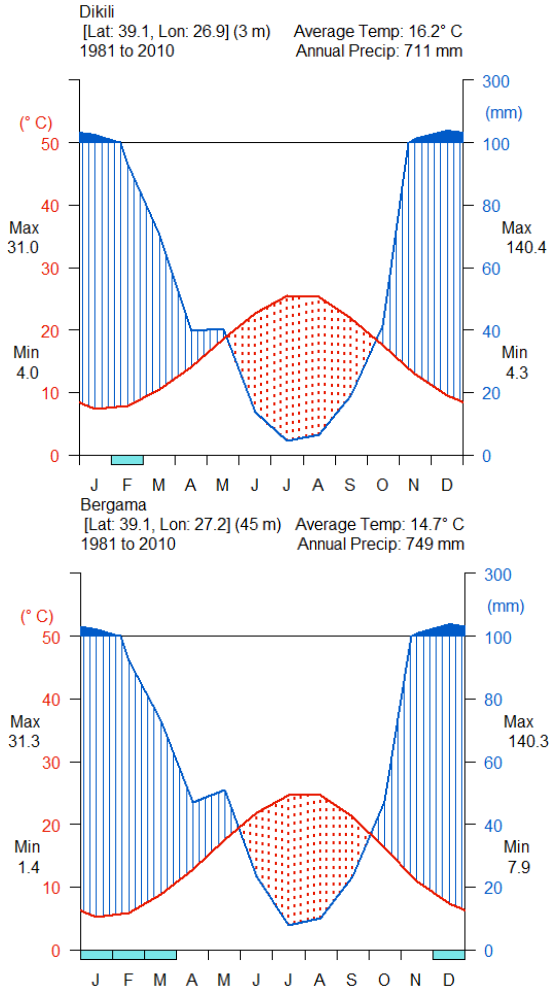
Figure 3. Climate diagrams of Dikili and Bergama (reference period: 1981–2010), showing Mediterranean subhumid climate with arid conditions prevailing during summer months and extreme rainfall during winter months. Data: Climatic Research Unit (CRU) (database: http://data.ceda.ac.uk/badc/cru/data/cru_ts/cru_ts_4.01/data, last accessed 8 November 2020) [79]. Between 9 and 3 ka BP, climate conditions in the eastern Mediterranean